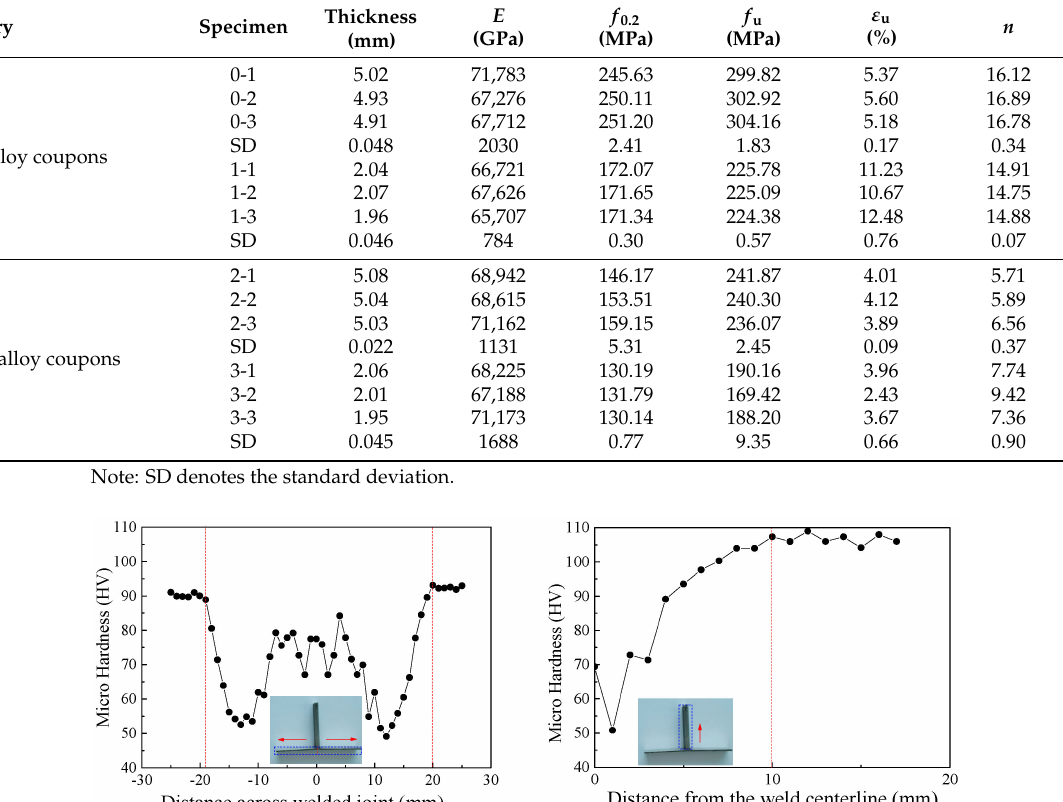
Table 2. Measured material properties.